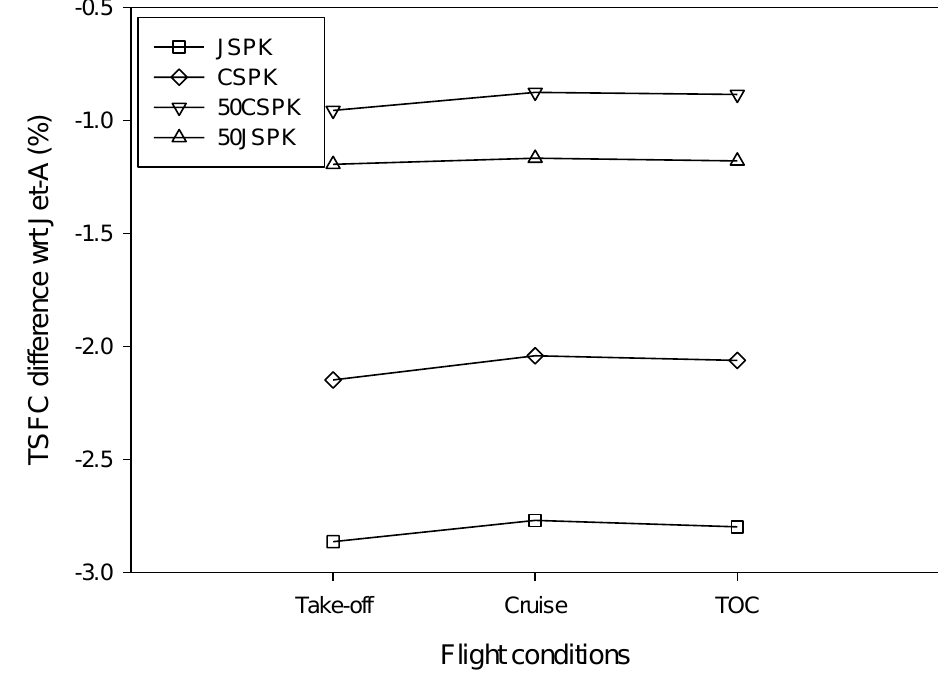
Figure 5. TSFC difference of biofuels compared to